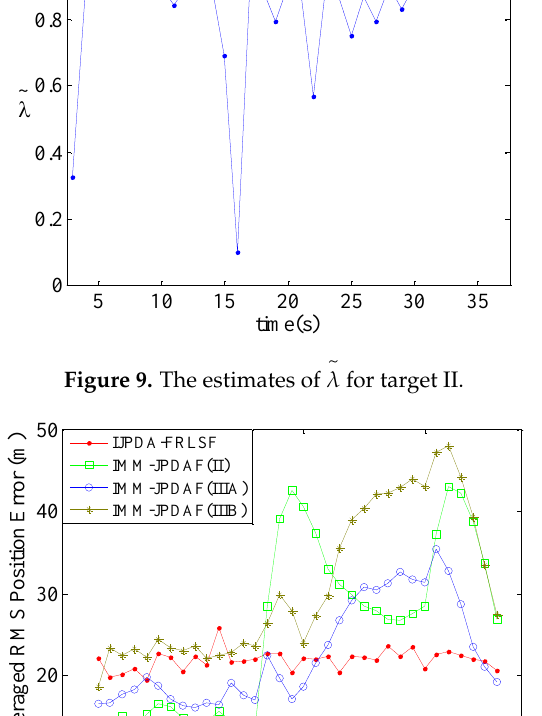
Figure 8 . The estimates of for target I.